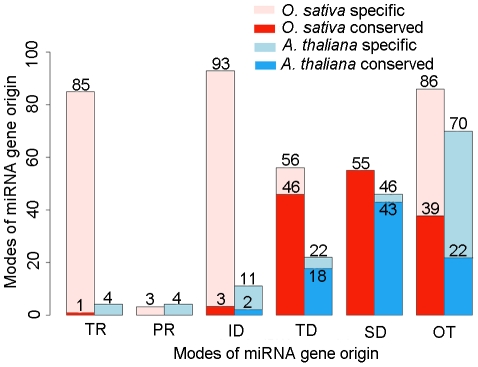
Quantitative contributions of different miRNA gene origin modes in O. sativa and A. thaliana genomes.Horizontal axis indicates origin modes of miRNA genes, TR represents TE-related, PR represents pseudogene-related, ID represents inverted duplication, TD represents tandem duplication, SD represents segmental duplication, and OT represents other miRNA genes could not fit any above-mentioned categories. Vertical axis indicates miRNA gene number. Mistyrose bars represent O. sativa specific miRNA genes. Red bars represent conserved miRNA genes (both present in O. sativa and A. thaliana) in O. sativa genome. Lightblue bars represent A. thaliana specific miRNA genes. Blue bars represent conserved miRNA genes (both present in O. sativa and A. thaliana) in A. thaliana genome.